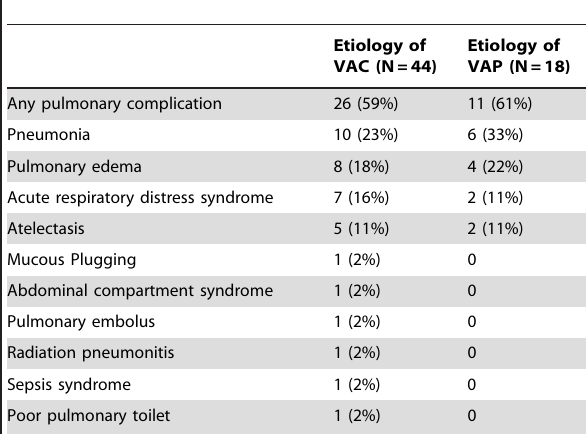
Table 5. Qualitative analysis of 52 patients flagged with ventilator-associated complications or ventilator-associated